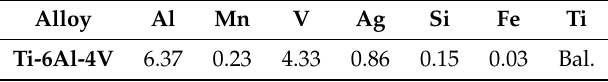
Table 1. Chemical composition (wt %) of the Ti-6Al-4V